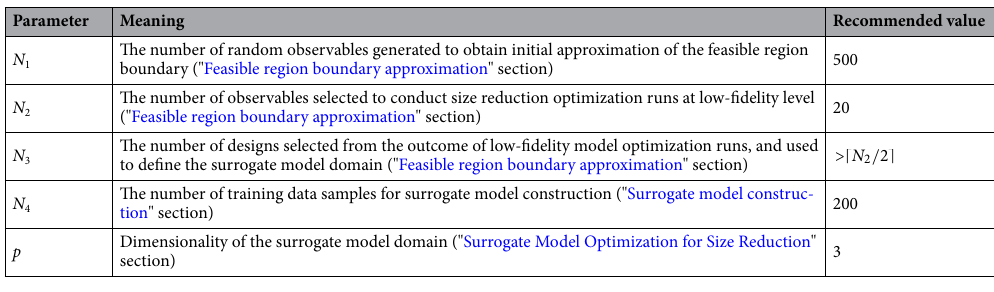
Table 3. Control parameters of the proposed globalized size reduction algorithm.